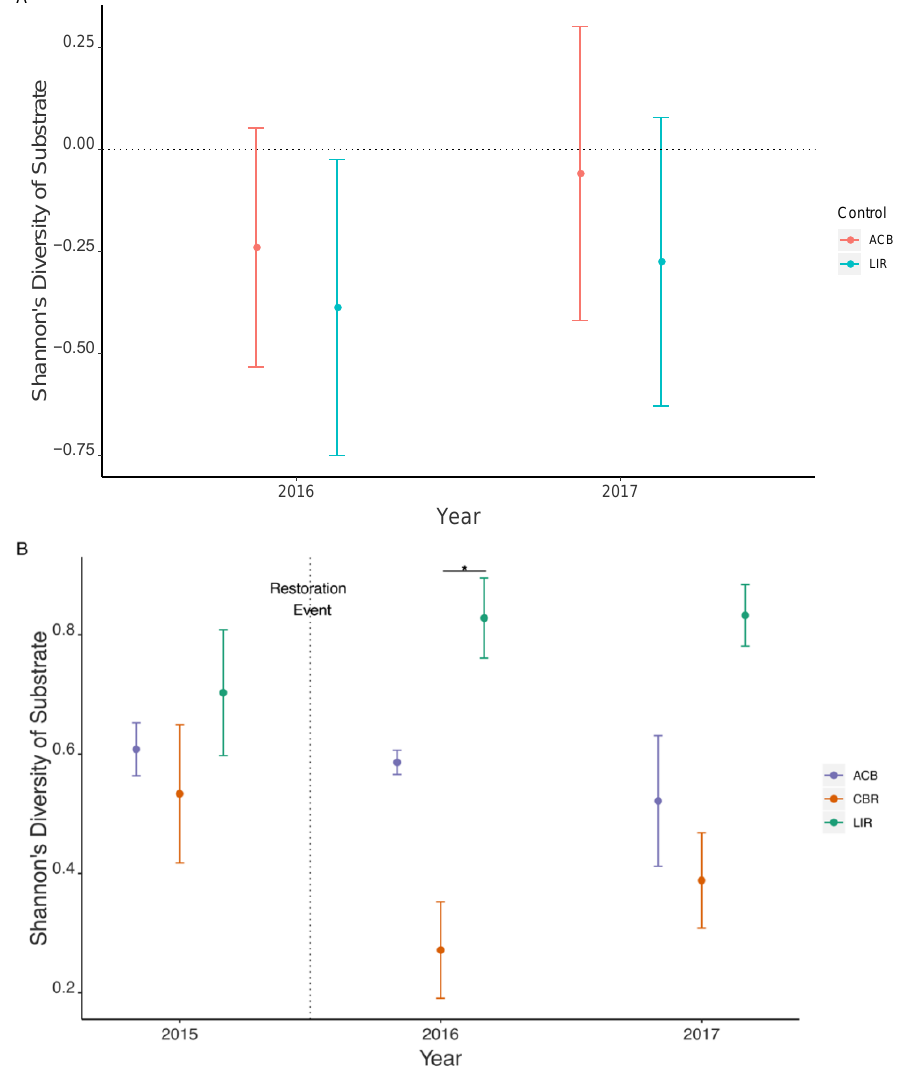
Figure 5. Shannon’s diversity of substrate (H sub ) as given by BACI effect size ( A ) and actual values with standard error ( B ). Significant differences are noted by confidence interval range not overlapping zero ( A ) while pairwise Welch’s t -tests with significant differences (α = 0.008) between CBR and other treatments within each year are marked with (*) ( B) . ACB = active cranberry bog, CBR = cranberry bog restoration, LIR = least impacted reference. All statistical comparisons are listed in Supplemental Table S4A and Supplemental Table S5B.